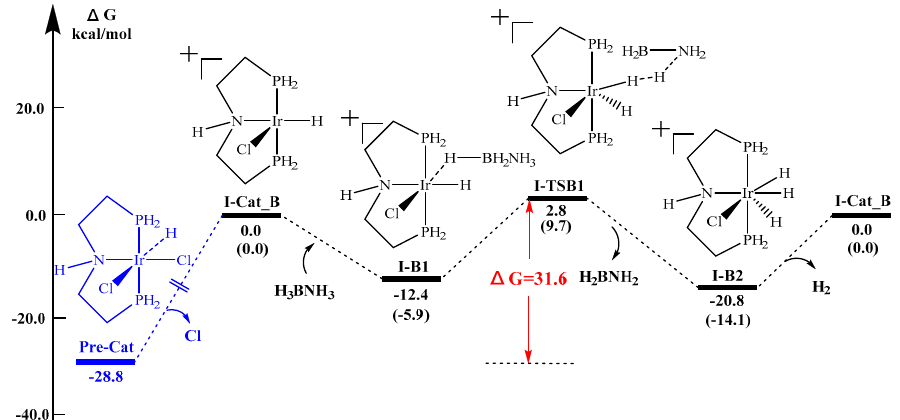
Figure 5. Reaction potential energy surface (kcal/mol) of Pathway I-B. Energies are calculated at B3LYP/LanL2DZ-6-311++G(d,p) in the solvent THF and H 2 O (in